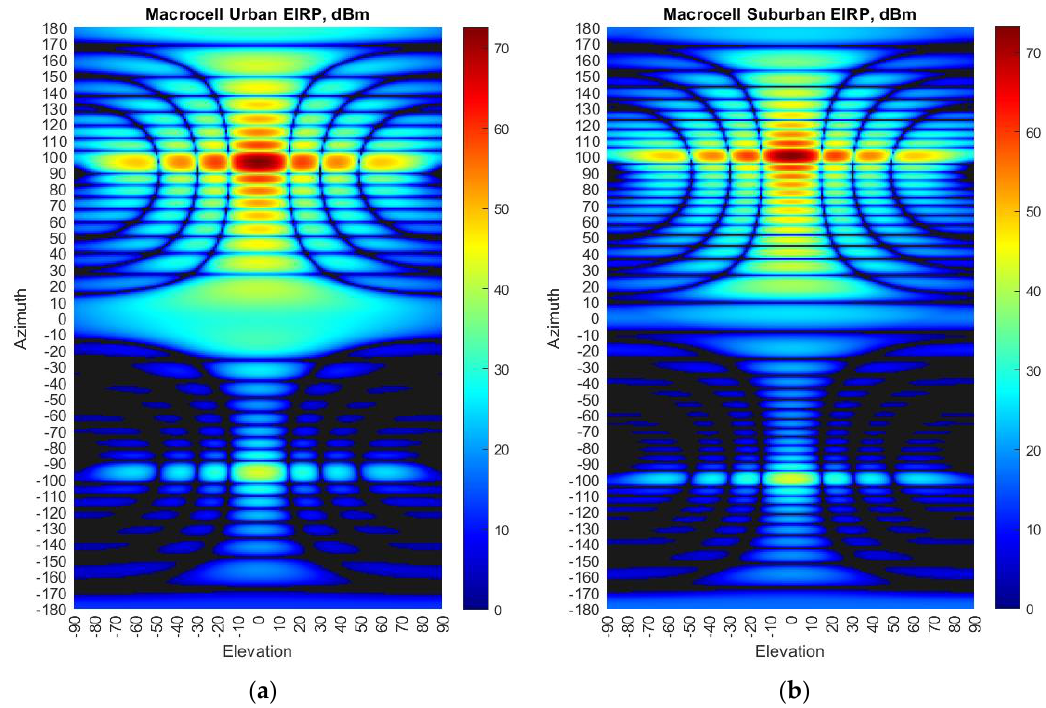
Figure 6. EIRP distribution in azimuth and elevation plane of 5G base stations ( a ) Urban deployment; ( b ) Suburban deployment.